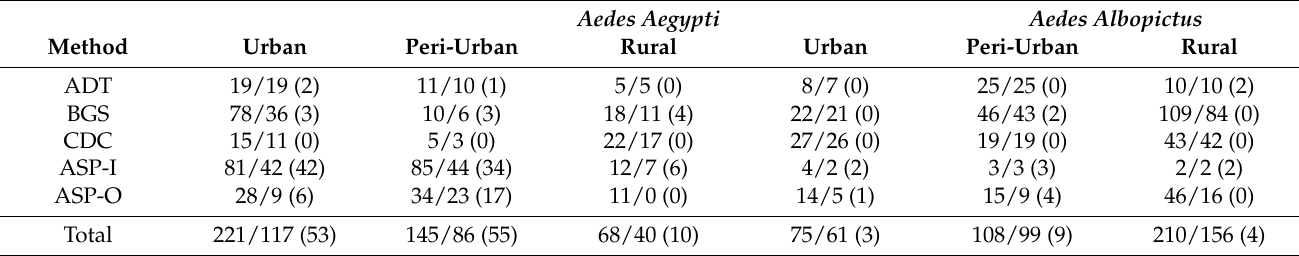
Table 1. Total number of Ae. aegypti and Ae. albopictus specimens collected by each collection method in three different landscapes. The numbers presented are the total number of collected mosquitos/the total number of females (engorged